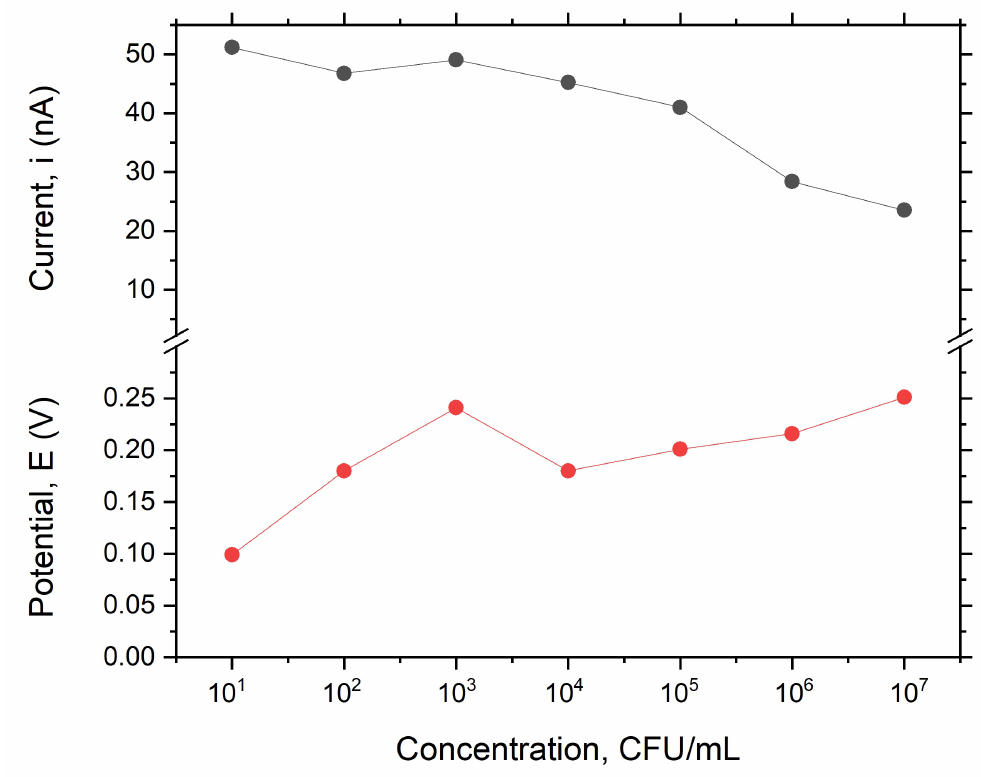
Figure 6. Variation in peak current and potential with E. coli